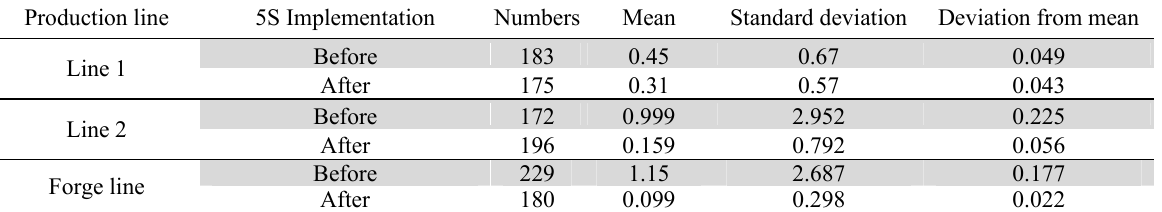
The results of some basic statistics before/after 5-S implementation in terms of the number of wastes Production